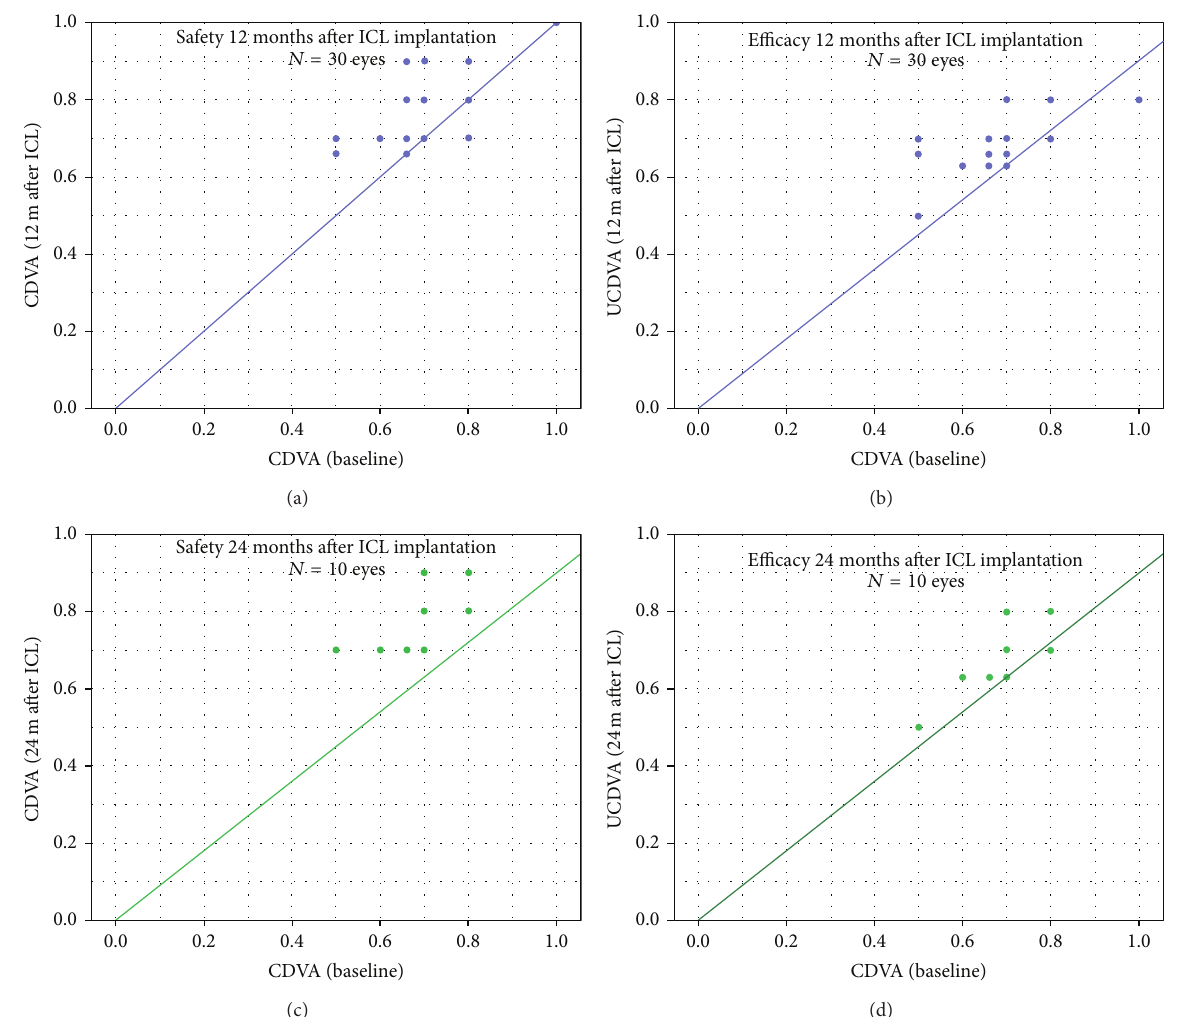
Figure 3: Safety and efficacy graphs comparing preoperative corrected distance visual acuity (CDVA) and uncorrected distance visual acuity (UDVA) 12 months (a, b) and 24 months (c, d) after